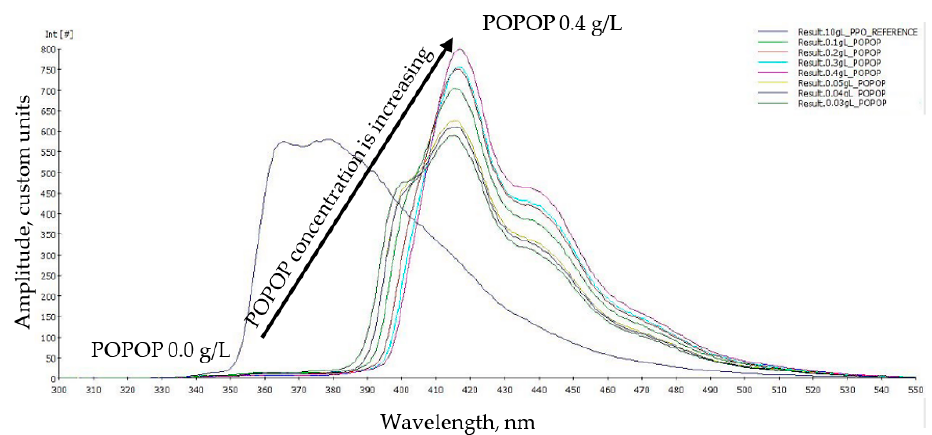
Figure 8. Scintillator output light spectrum for different POPOP concentrations.